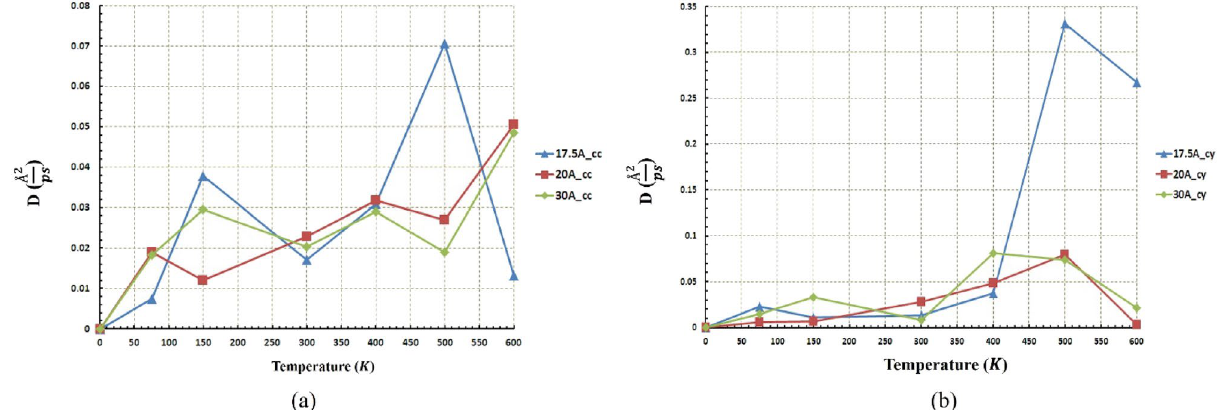
Figure 15. Diffusion coefficient of the nanotruck at different temperatures and radii ( a ) for the concave (cc) substrates and ( b ) for the cylindrical (cy) substrates. Naotruck’s diffusion coefficient in concave geometry for 2 ) . In addition, nanotruck’s diffusion coefficient is lower than 0.01 ( Å all radii is lower than 0.01 ( Å ps except the radius of 17.5 Å at 500 K and 600 K in cylindrical geometry.